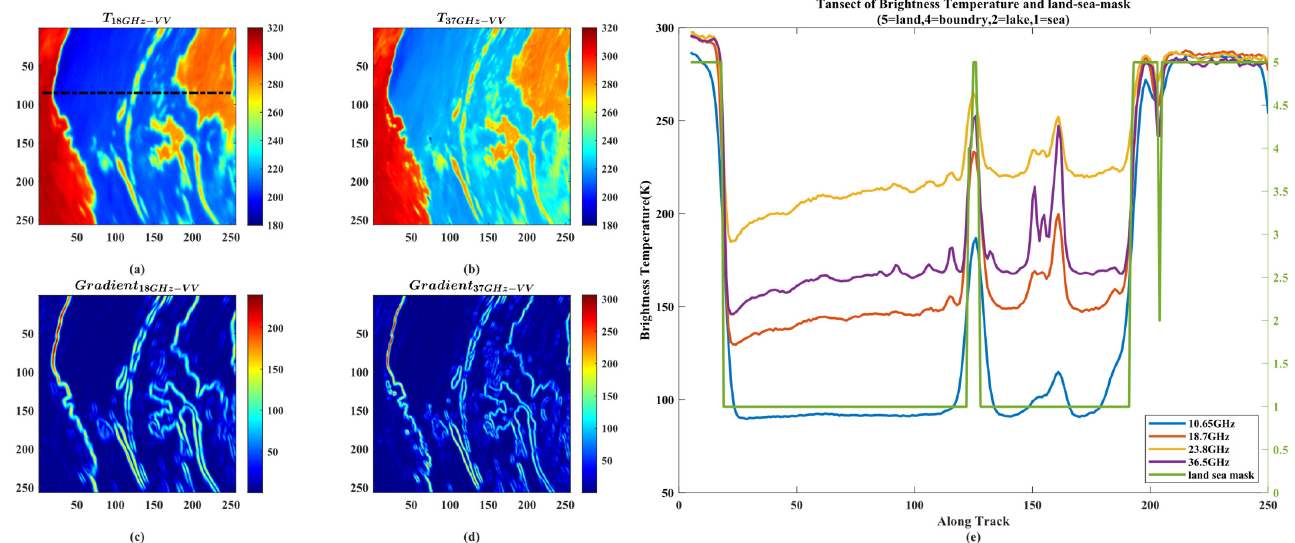
Figure 5. Performances of the different frequency channels. ( a ) 18.7 GHz Vertical Polarization scene temperature; ( b ) 37 GHz Vertical Polarization scene temperature; ( c ) the gradient of 18.7 GHz Vertical Polarization scene temperature; ( d ) the gradient of 37 GHz Vertical Polarization scene temperature; ( e ) the along-track transects of the synthetic scenario (labeled with the dash-dotted line in ( a )). Specifically, the relationship between 18 and 37 GHz of the whole image can be defined as the ratio 𝑅 :